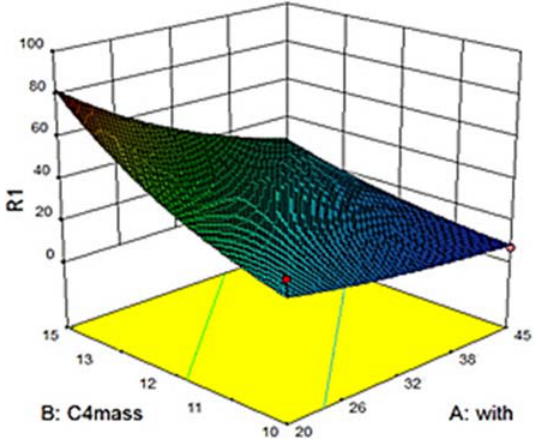
Figure 28: 3D graph for pea pumice. Figure 29: Displacement changes by changing the explosion charge for pea